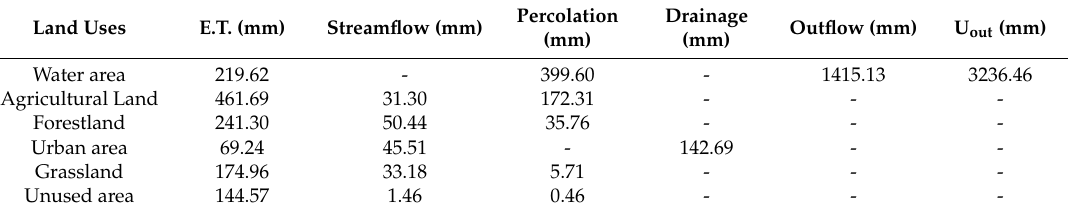
Table 7. Outflows of the six land use types of the middle reach of Heihe River basin.